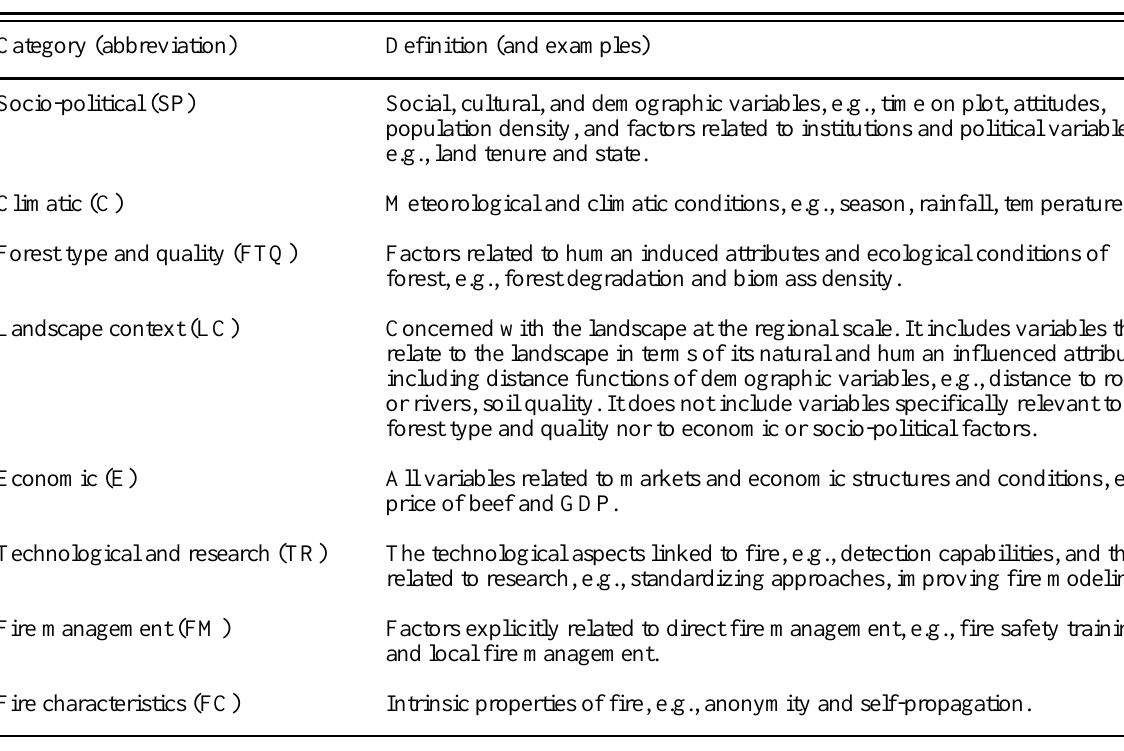
Table 1. Category definition used to group the factors and solutions related to fire extent and